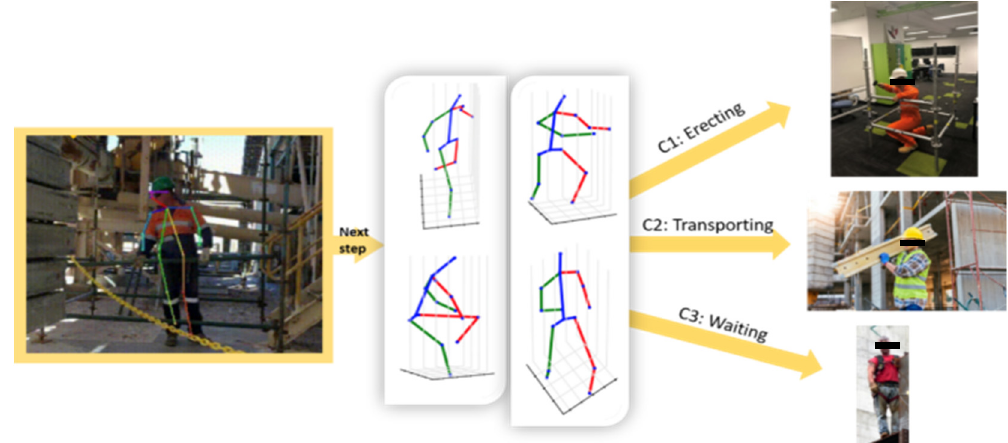
Figure 4. Scaffolding activity categories: Scaffolding activities are classified into erecting (direct work), transporting (essential contributory work) and waiting or idling (ineffective work).